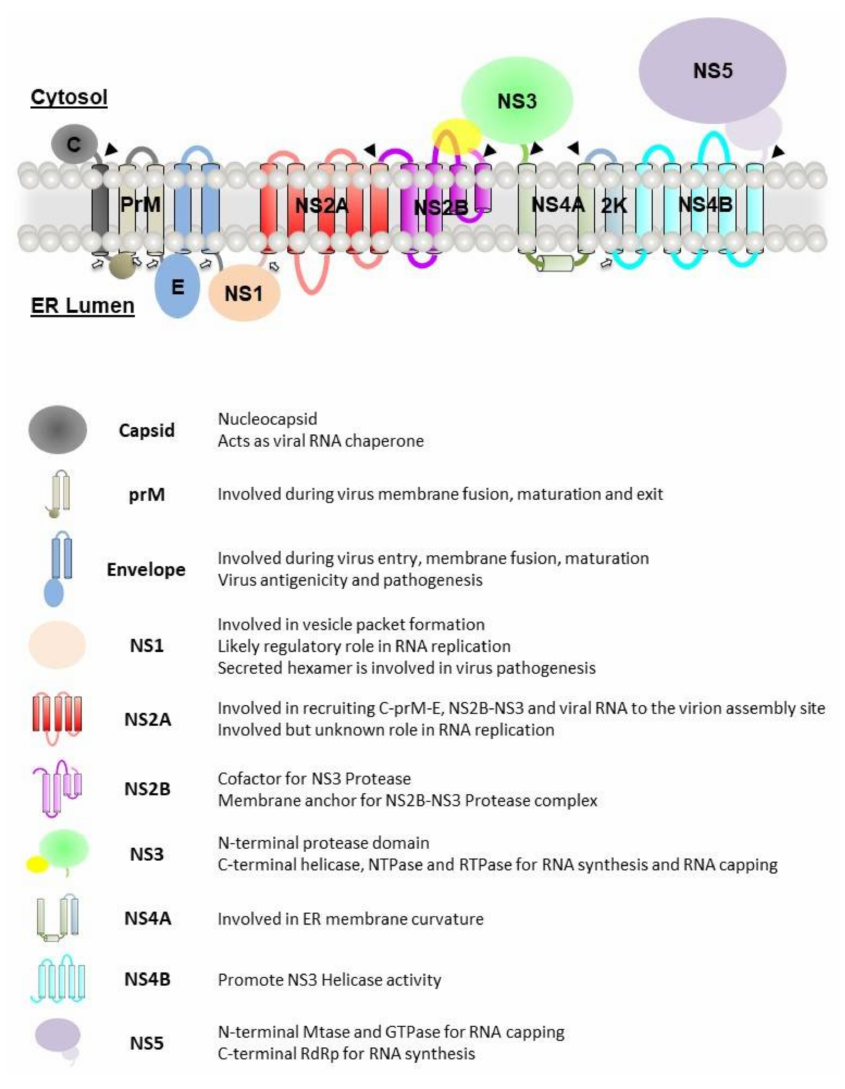
Figure 3. Cartoon representation of the flavivirus polyprotein. The cleavage site of viral protease is represented by a solid arrow, while the cleavage site by host protease is represented by an open arrow. A summary of the function of the viral proteins is